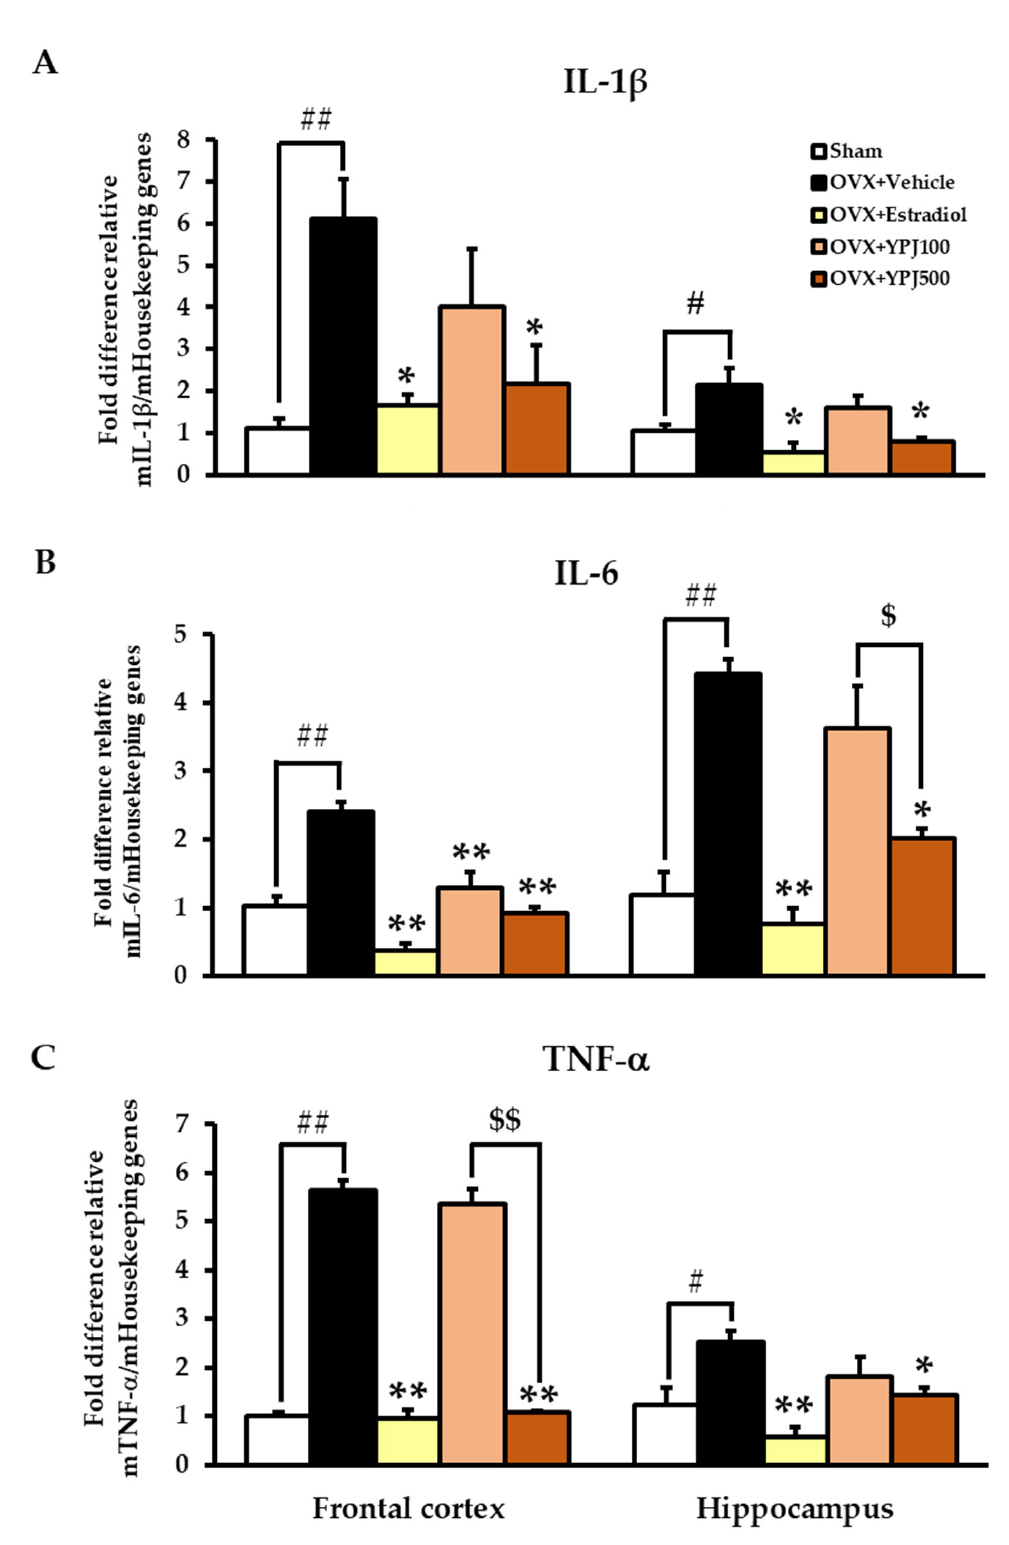
Figure 6. The effect of YPJ formula on inflammatory cytokine expression in the frontal cortex and hippocampus of OVX mice. ( A ) IL-1 β , ( B ) IL-6, and ( C ) TNF- α . Data represent the mean ± SEM ( n = 5). Significant effects are represented # p < 0.05, ## p < 0.001 vs. sham, * p < 0.05, ** p < 0.001 vs. vehicle-treated OVX mice, $ p < 0.05, $$ p < 0.001 between doses of YPJ (post hoc Tukey test).